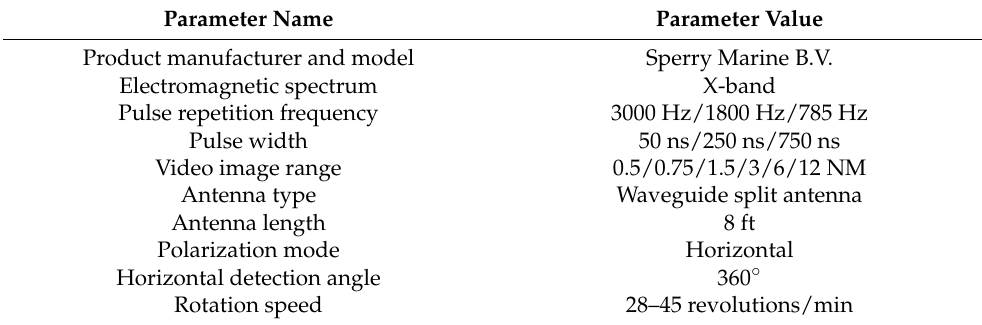
Table 1. The shipborne radar-specific